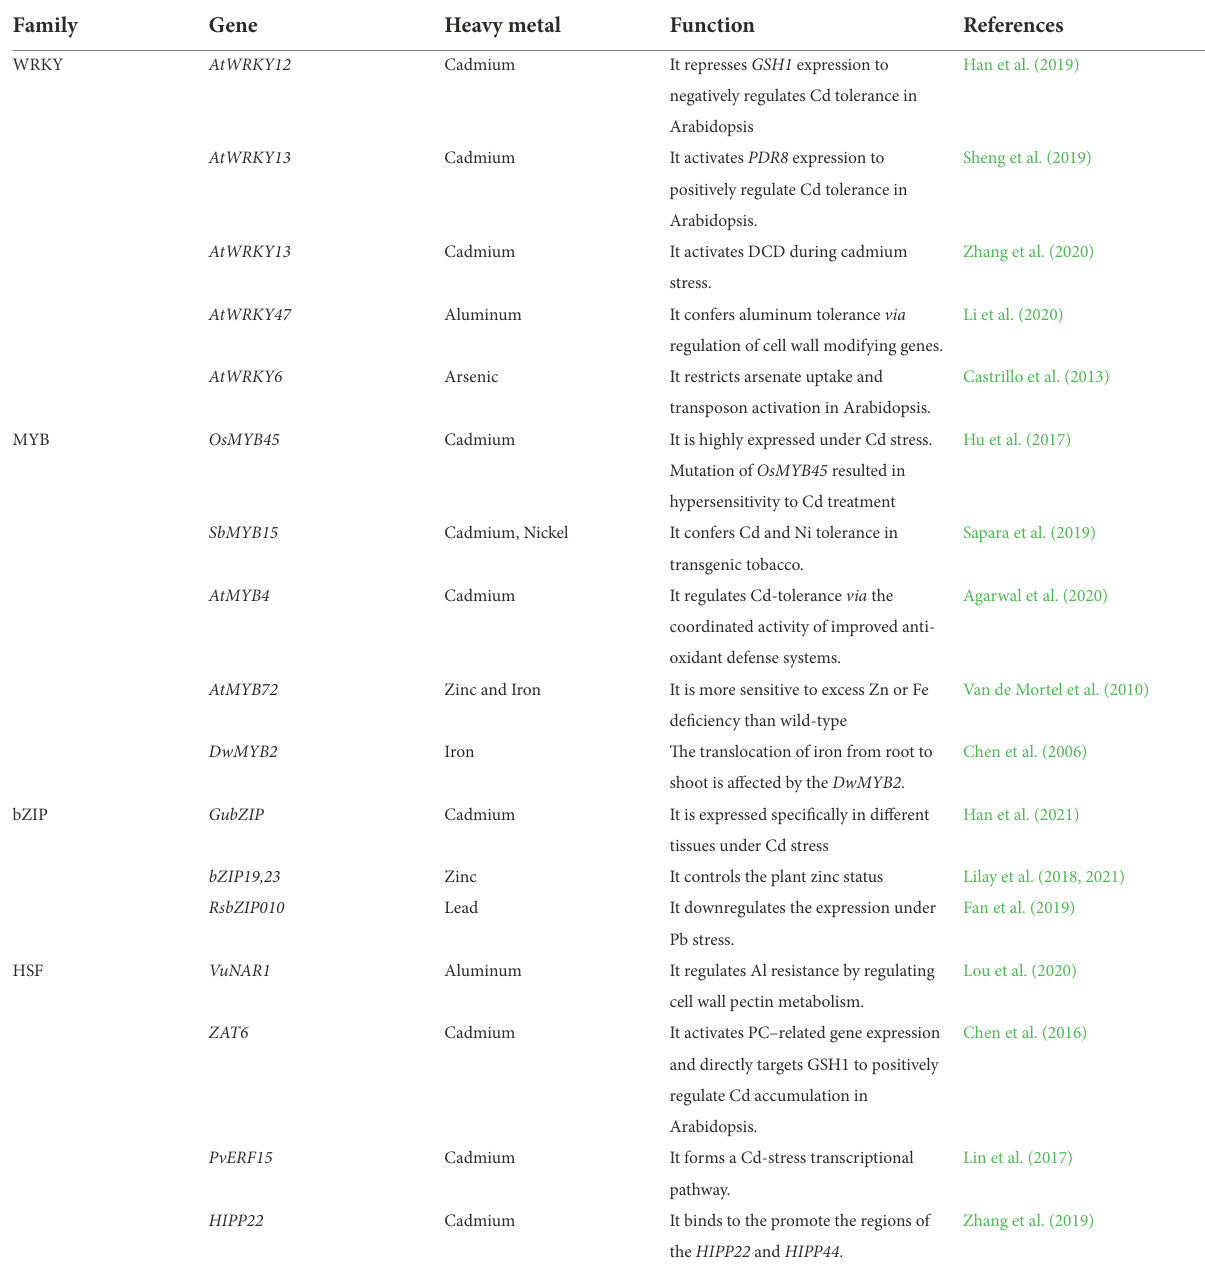
TABLE 2 TFs in response to heavy metal stresses (Li et al., 2022).